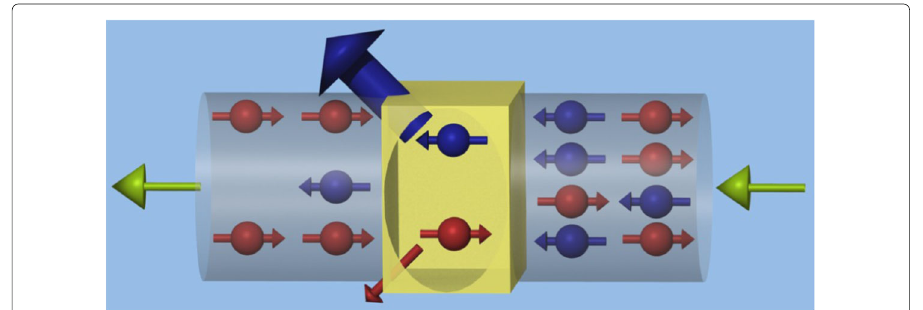
Fig. 1 Spin-filtering concept. The spin-dependence of the hadronic interaction cause a selective discard of one spin state of the stored particles